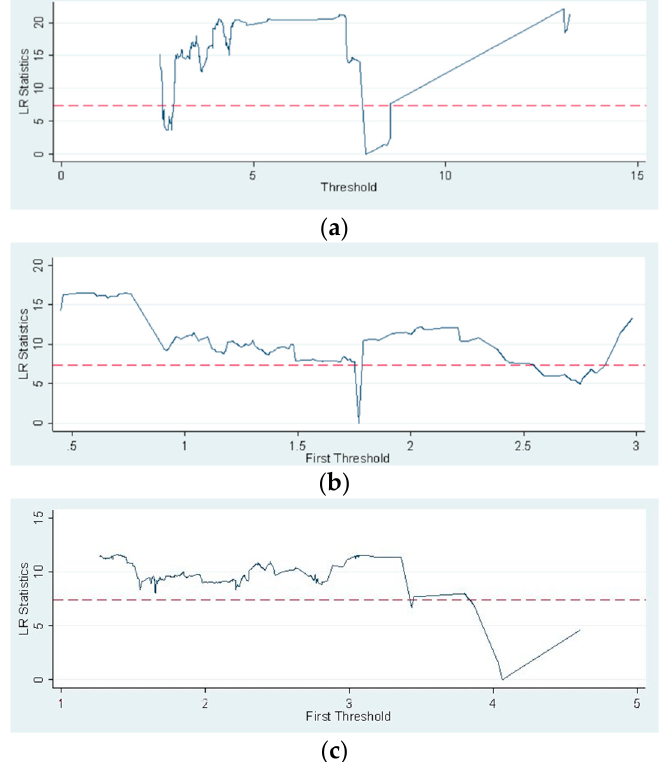
Figure 4. The LR statistics value trend estimated for the threshold variable. ( a ) Decentralization level; ( b ) Governance input level; ( c ) APHD level. And, the dashed line is the critical value of 7.35.